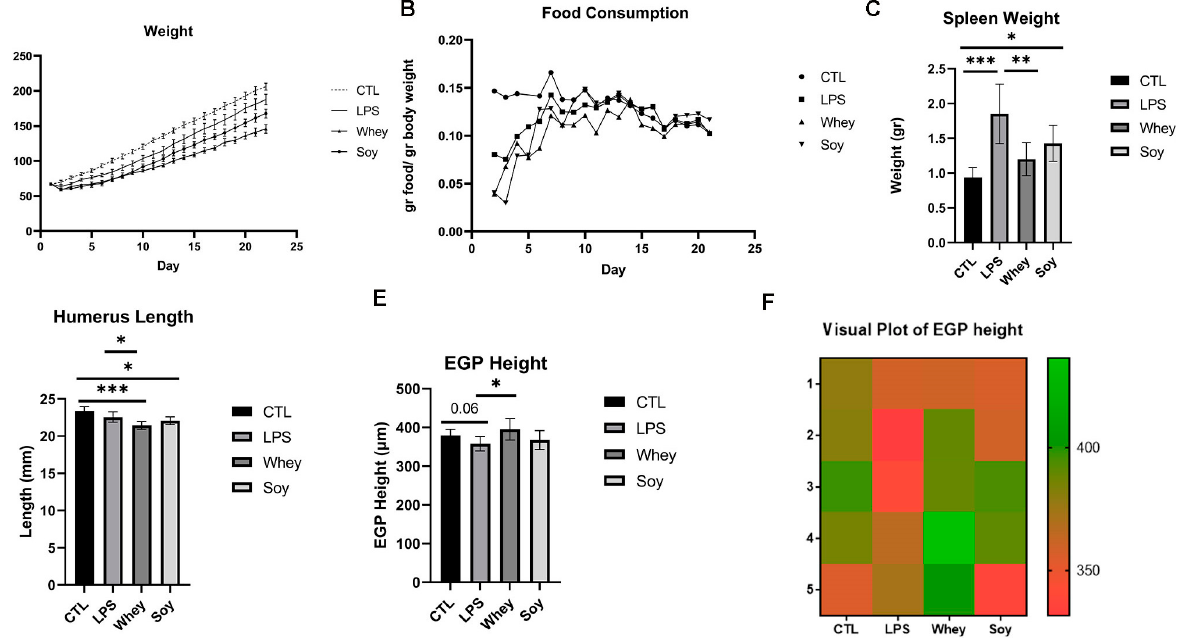
Figure 3. The effect of LPS and study diets on ( A ) weight, ( B ) food consumption, ( C ) spleen weight, ( D ) humerus length, ( E ) EGP height, ( F ) visual plot of EGP height, ( G ) representative stained sec- tions of EGP from all groups, ( H ) PZ height, ( I ) HZ height, ( J ) hypertrophic cell size, ( K ) PZ/HZ ratio. ANOVA was used; ( A – E , H – K ) mean ±SD values are shown (n = 5/6 per group). * <0.05; ** <0.01; *** <0.001; **** <0.0001. 3.3. Analysis of Cytokine Expression in the Spleen Toll-like receptor 4 (TLR4) is an innate immune receptor for LPS. The binding of LPS activates a TLR4 signaling cascade and stimulates the PI3K/Akt pathway and nuclear fac- tor κ B (NF- κ B) which triggers the subsequent biological effects [26]. We tested for multiple